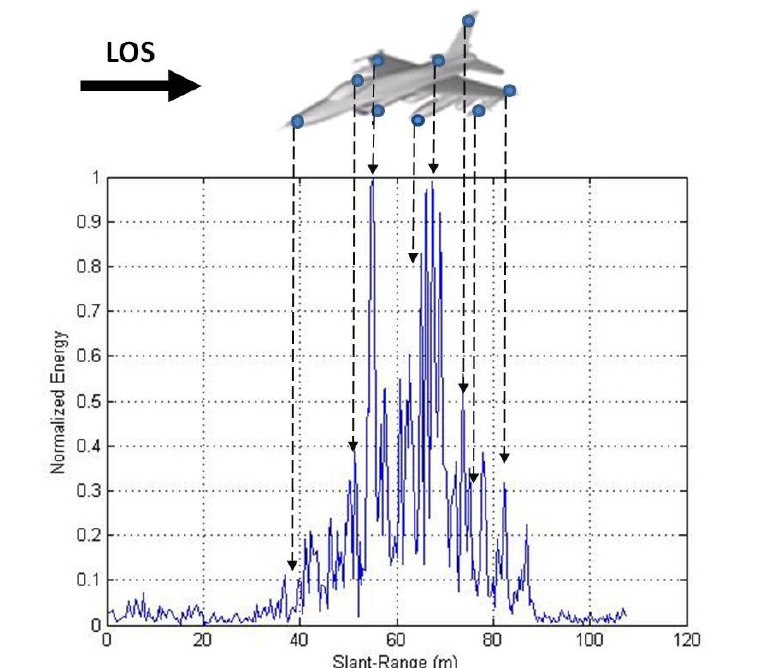
Figure 3. High resolution range